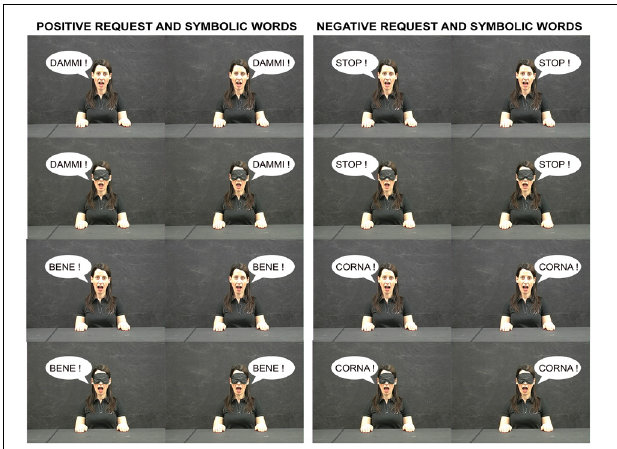
FIGURE 2 | Meaningful words shown by the conspecific (see the vignettes on the right and on the left) and presented in Experiment 3. The conspecific could be either blindfolded or not. The upper two rows show request words and the lower two rows show symbolic words. The two columns on the left show words with positive valence whereas the two columns on the right show words with negative